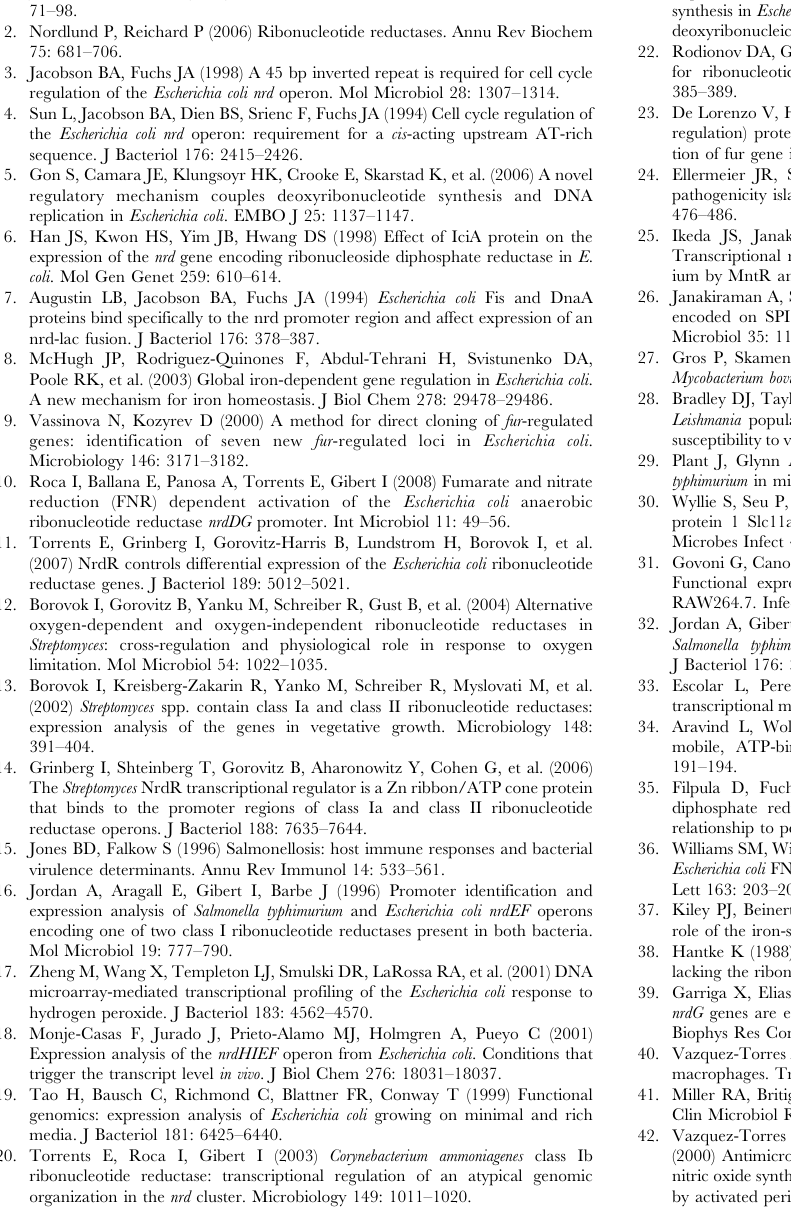
Figure S4 Effect of NrdR and Fur on macrophage